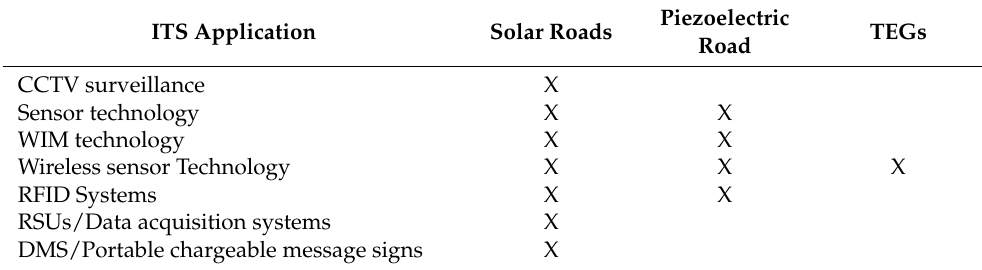
Table 9. Best harvesting techniques suitable for various ITS